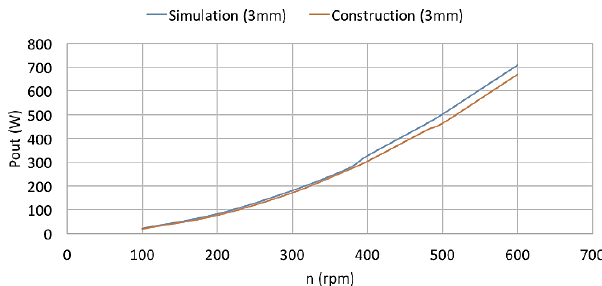
Figure 10. Plot versus the speed of the output power simulation and experimental results at 70 Ω/phase load.